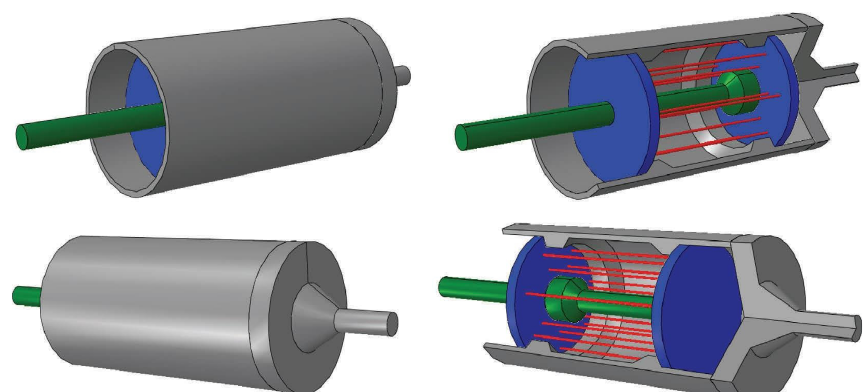
Figure 8: Te recommended damper equipped with SMA